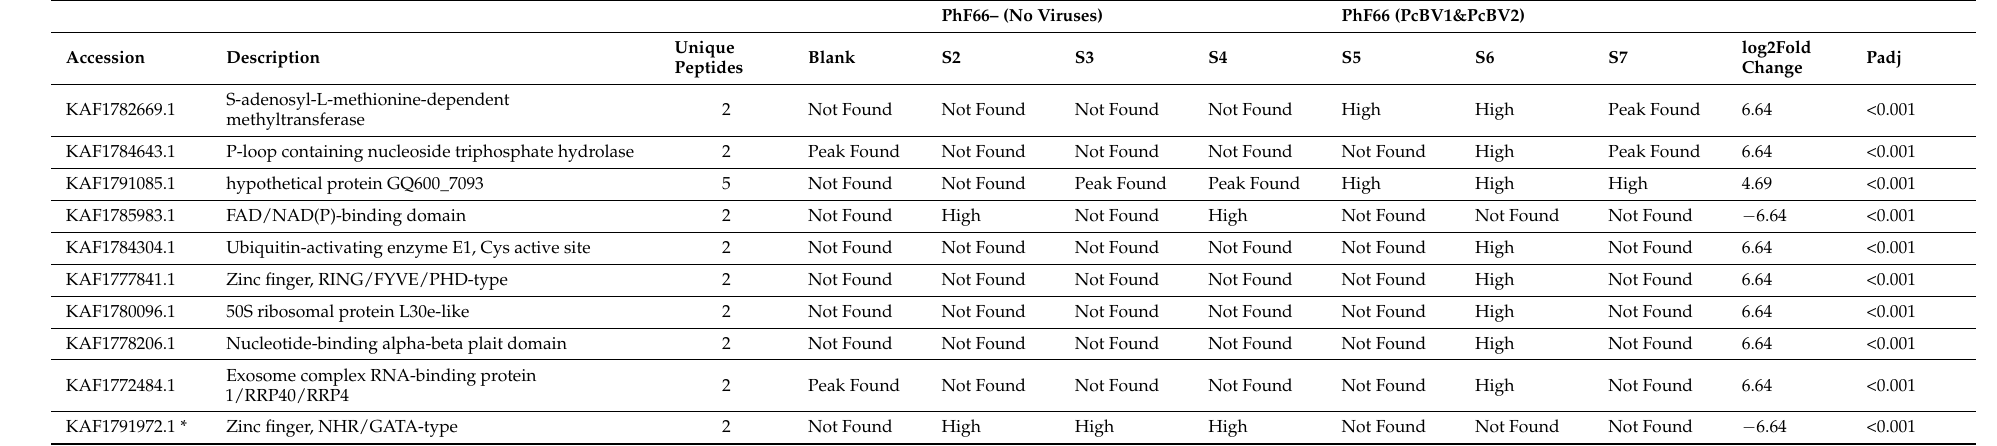
Table 4. Differentially abundant proteins ( p < 0.05) in the virus free PhF66– (samples S2–4) and PhF66 (samples S5–7) containing two bunyaviruses by RNA-seq. * = proteins also found differentially expressed in RNA-seq ( p < 0.05). “High” and “Peak Found” represent proteins identified by matching peptide MS/MS spectra and proteins that were identified by matching combinations of expected peptide mass and retention time, respectively. Annotated elicitins are highlighted in